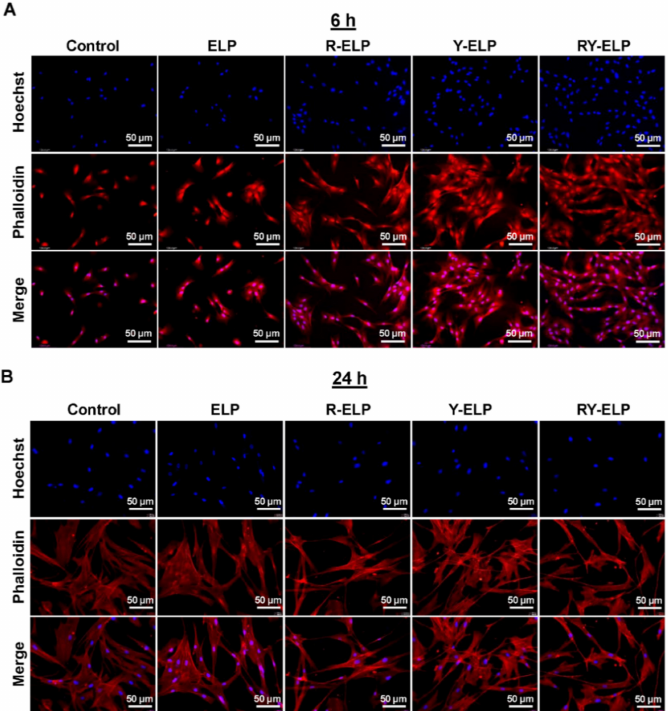
Figure 4. Determination of focal adhesion formation by Phalloidin staining. MSCs was seeded on fusion-ELP-coated coverslips for various time intervals and the adhered cells were fixed and labeled for nuclei (blue) by Hoechst 33,258 and actin filament (red) phalloidin–TRITC, respectively. Representative fluorescence microscopy images of MSCs adhering on the fusion-ELP-coated surface at 6 h ( A ) and 24 h ( B ), Scale bars: 50 µ